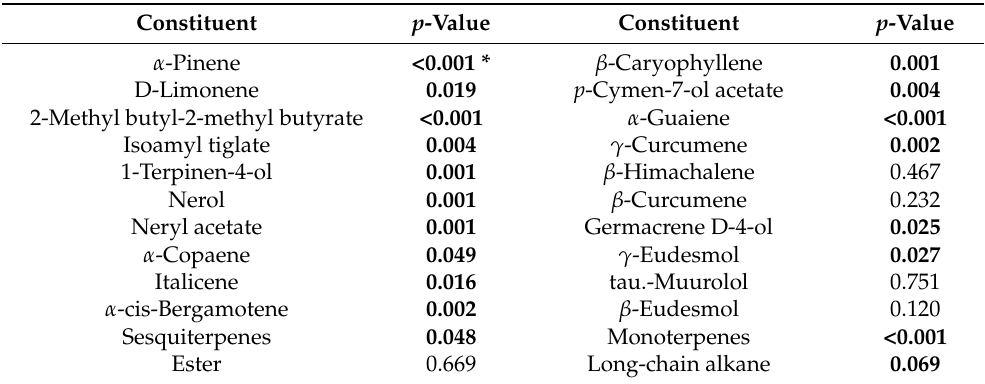
terms of H. italicum